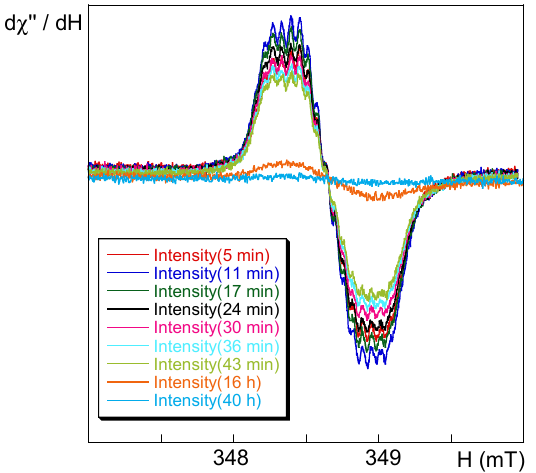
Figure 2. Electron paramagnetic resonance (EPR) spectral evolution with time for an equimolecular solution of 1 and pyrrolidine. Experimental details of the data collection: modulation amplitude 0.1 mT, time constant 40.96 ms, conversion time 327.68 ms, gain 6.32 × 10 4 , power 20 mW, and micro- wave frequencies 9.7410 (5 min), 9.7410 (11 min), 9.7410 (17 min), 9.7410 (24 min), 9.7460 (30 min), 9.7410 (36 min), 9.7410 (43 min), 9.7410 (16 h), and 9.7760 (40 h) GHz.